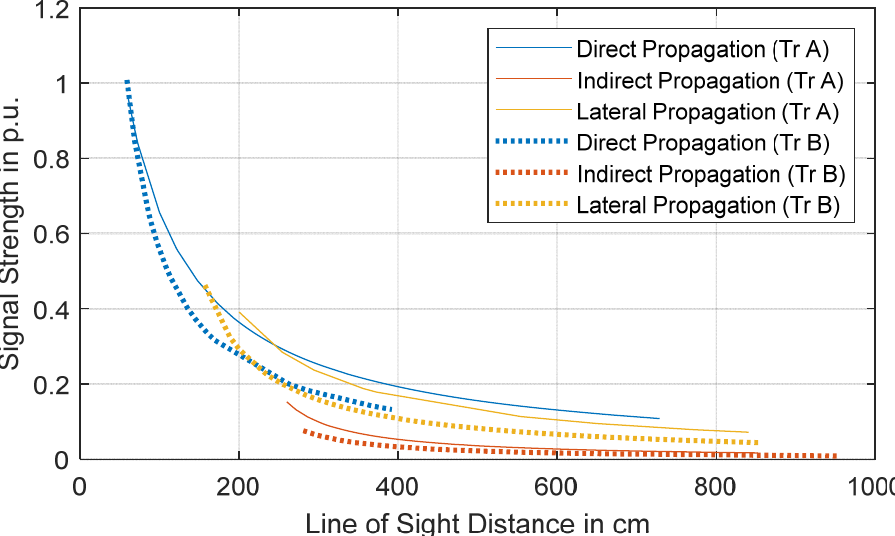
Figure 3. Comparison of signal attenuation based on the type of propagation in transformers A and B [22].